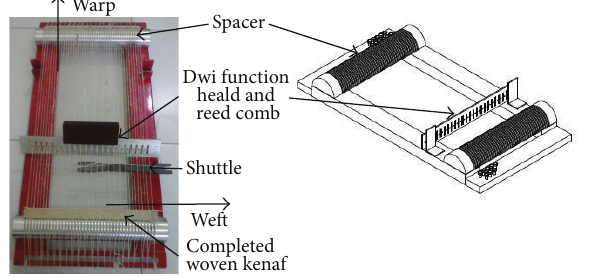
Figure 2: Completed woven